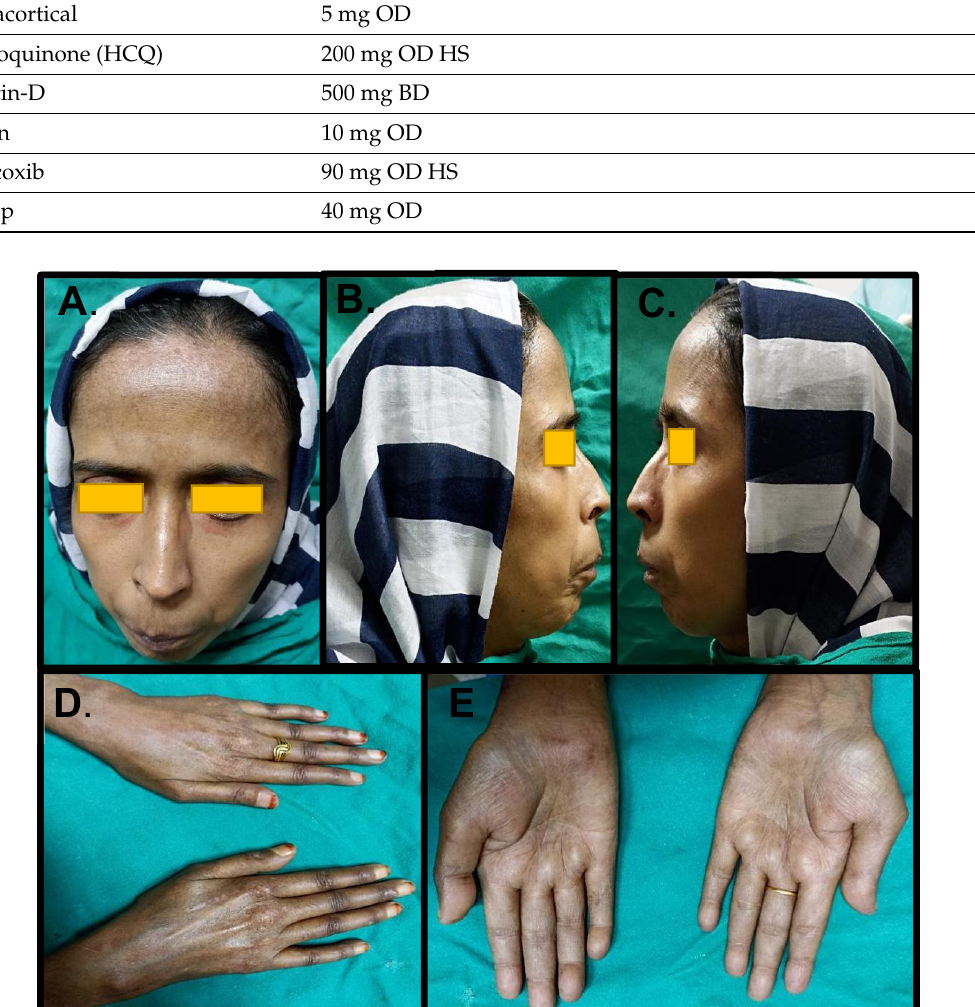
40 mg OD There was considerable weight loss with fluctuating jaundice since 2016, and her blood sugar values and blood pressure were within the normal range. Physical examina-